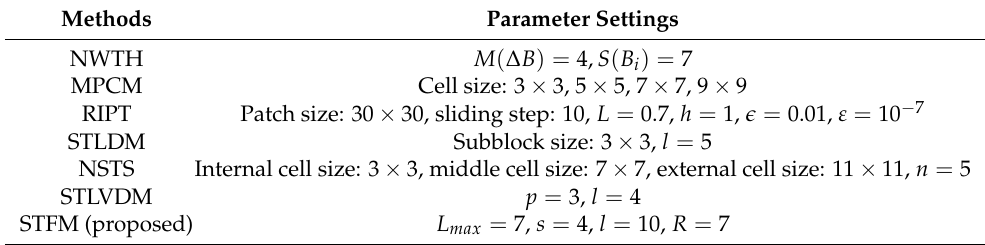
Table 2. Parameter settings of baseline methods.